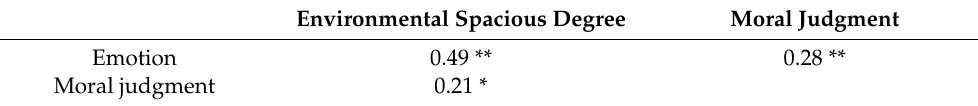
Table 3. The correlation between emotion, environmental spacious degree and the moral